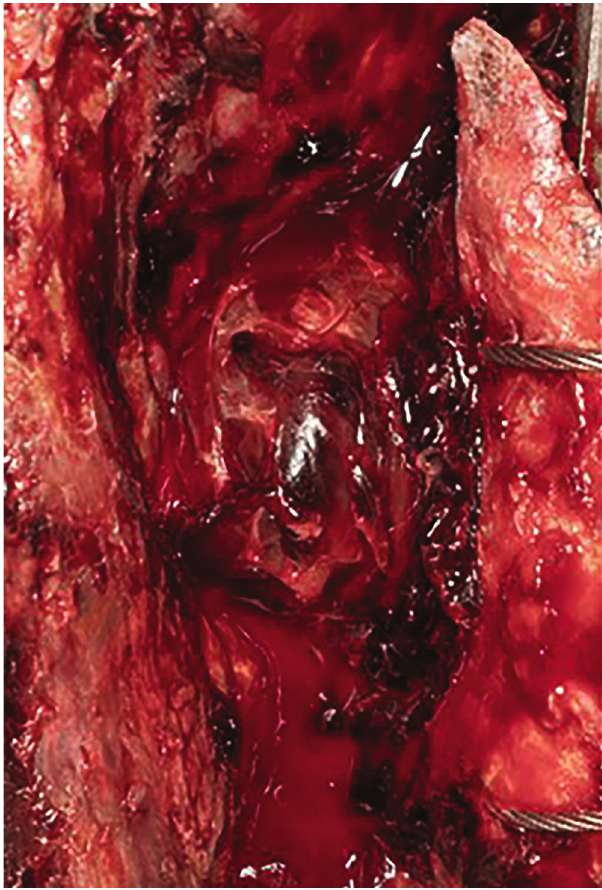
Figure 6: Pseudoaneurysm appreciated on the posterolateral aspect of the femur.